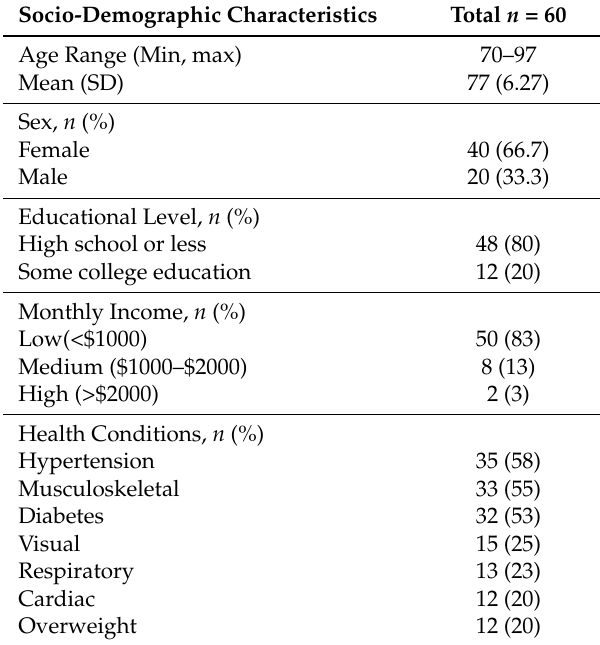
Table 1. Socio-demographic characteristics of the participants.